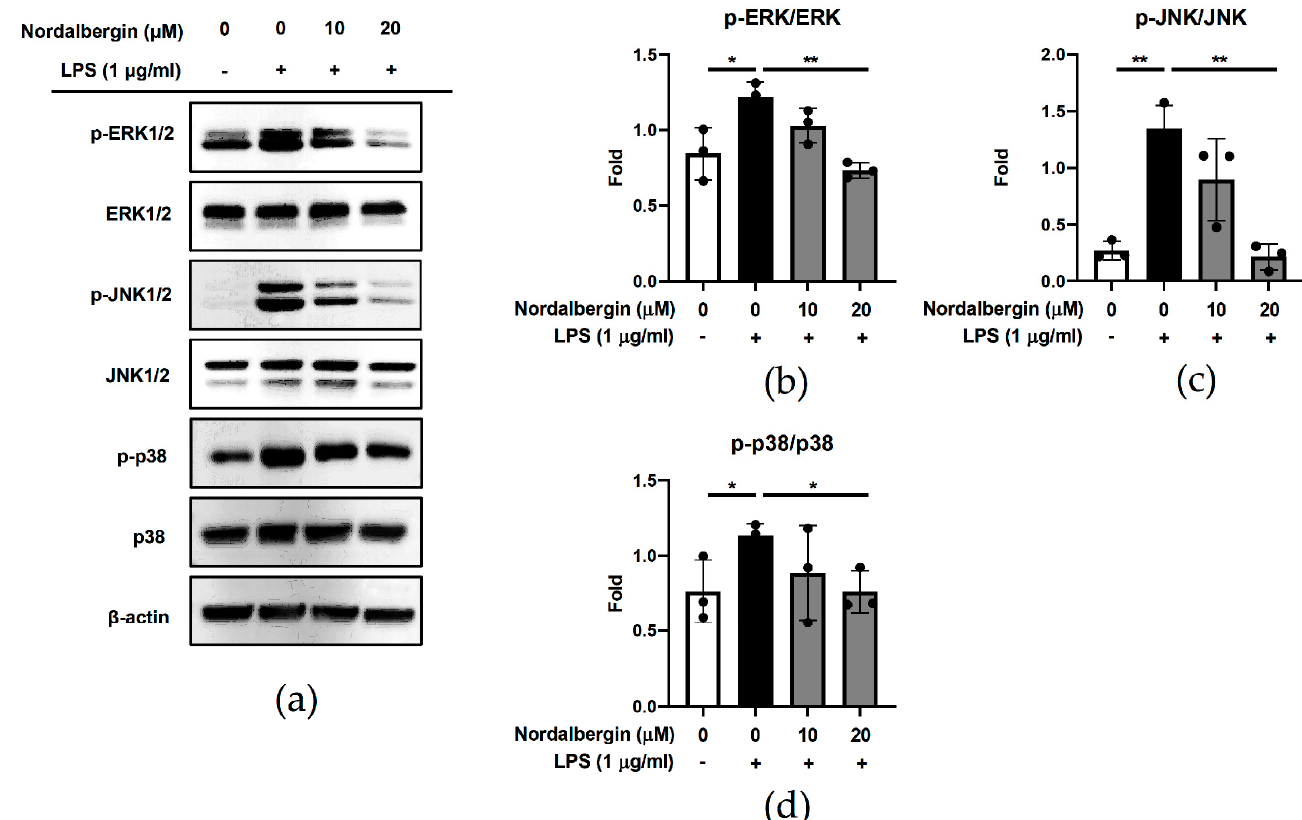
Figure 3. E ff ect of nordalbergin on the activation of MAPKs signaling pathways by LPS-stimulated BV2 cells. Cells were pretreated with nordalbergin (0–20 µM) for 30 min and then primed with LPS for 2 h. ( a ) Phospho-ERK, ERK, phospho-JNK, JNK, phospho-p38 and p38 expressions were determined using Western blot, while β -actin expression was used as a loading control. Quantitative results are shown in ( b – d ). Data are shown as mean ± SD (n = 3; * p < 0.05, ** p < 0.01).